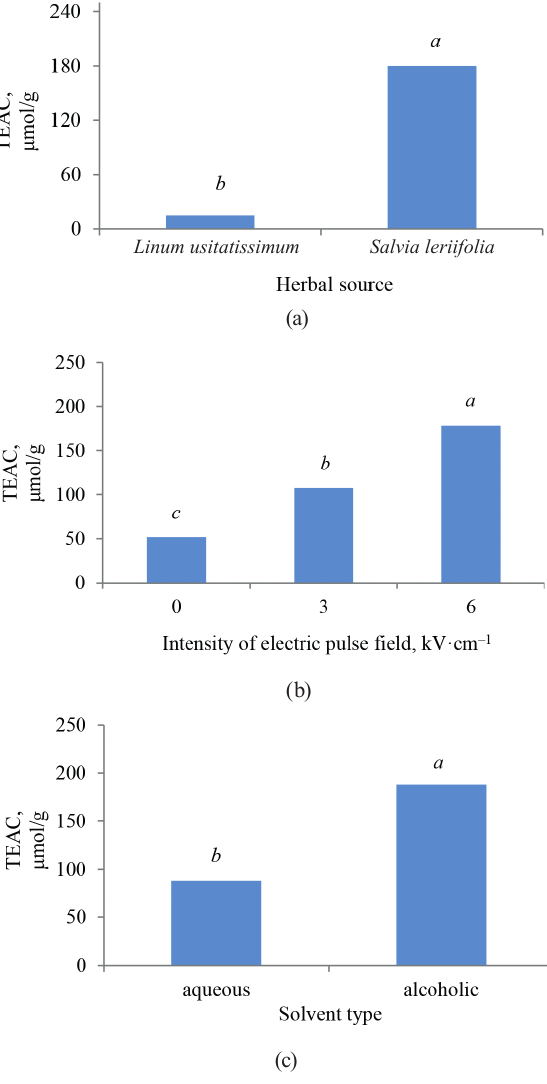
Figure 5 Independent effects of herbal source (a), pre- treatment (b), and solvent type (c) on antioxidant activity by TEAC method ( P <